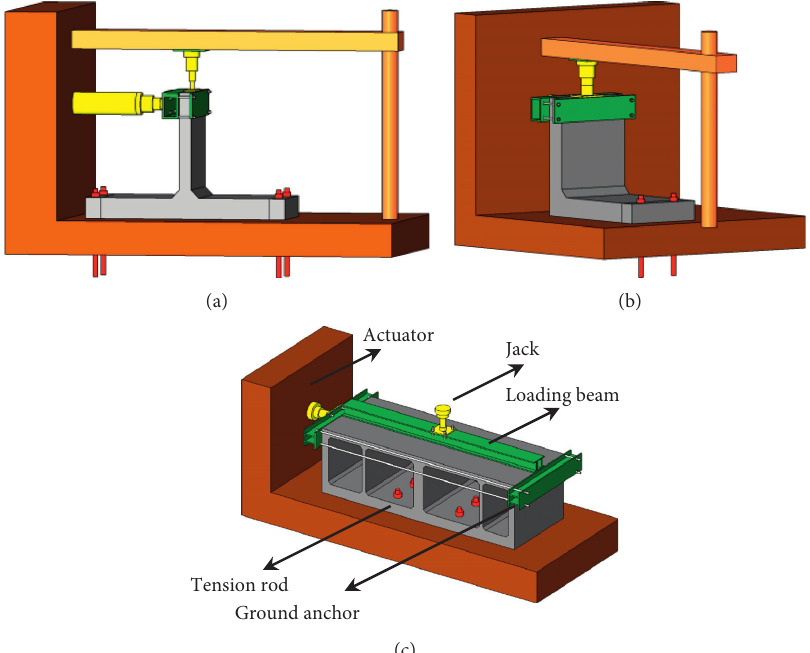
Figure 3: Schematic diagram of loading: (a) middle joint specimen; (b) side joint specimen; (c) overall specimen.